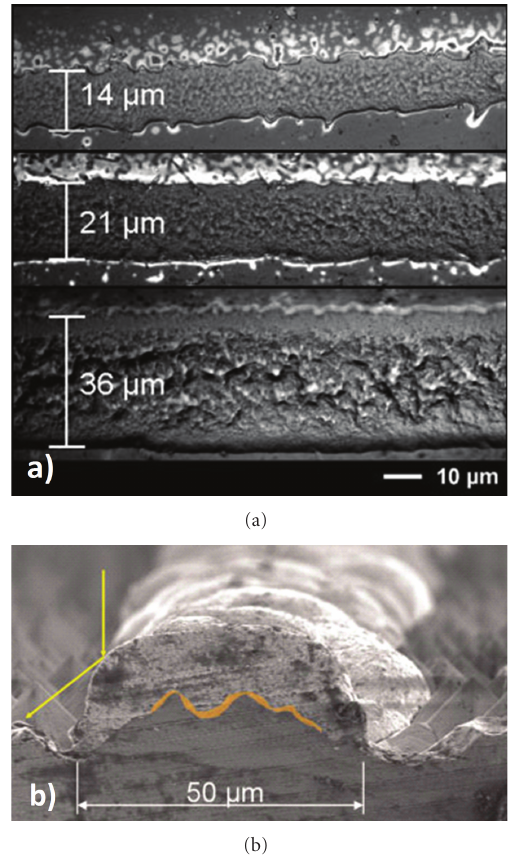
Figure 22: Aerosol Jet printed Ag traces for solar cells; (a) optical image prior to LIP, reprinted from Mette et al. [99], Copyright 2007, with permission from John Wiley & Sons LTD. (b) SEM image of cross-section of Aerosol Jet printed trace with LIP. Aerosol Jet printed seed layer is highlighted in orange, reprinted from Horteis and Glunz [100], Copyright 2008, with permission from John Wiley & Sons